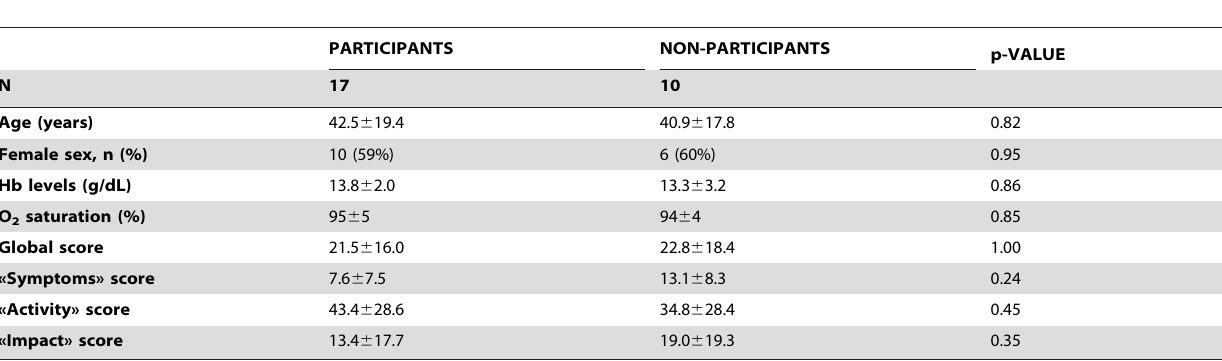
Table 2. Characteristics of the group C patients who participated in the evaluation of the impact of embolisation on the quality of life.